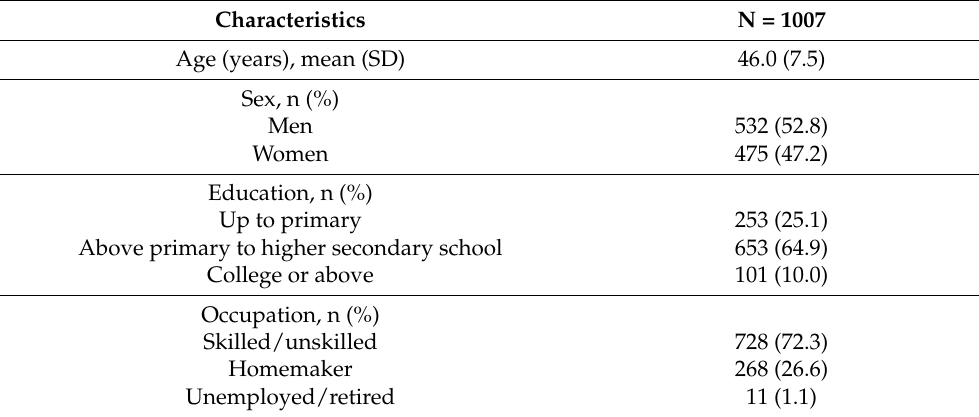
Table 1. Sociodemographic characteristics of the